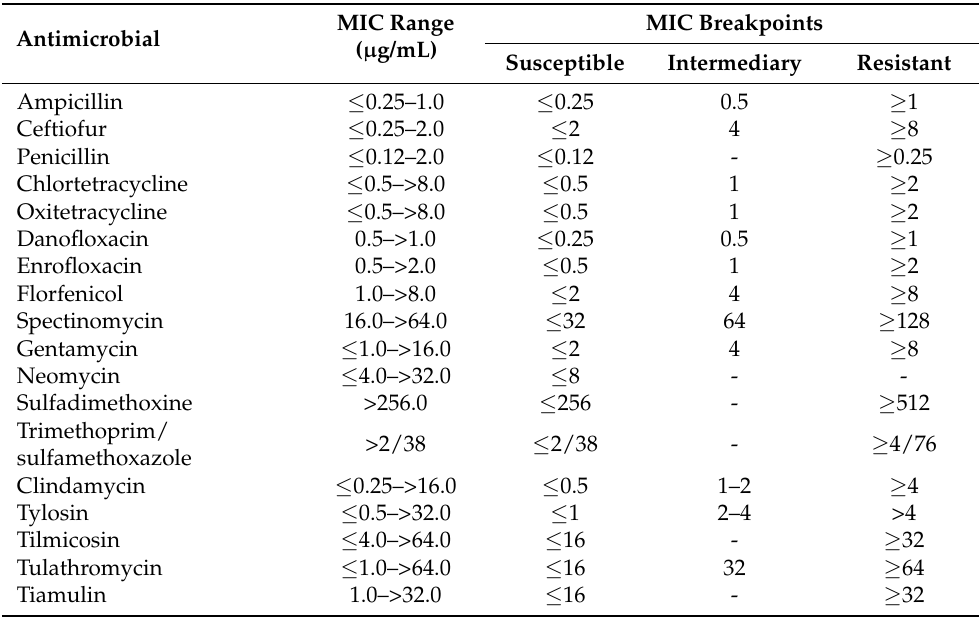
Table 1. Antimicrobials’ MIC range evaluated, and breakpoints applied to S. hyicus .